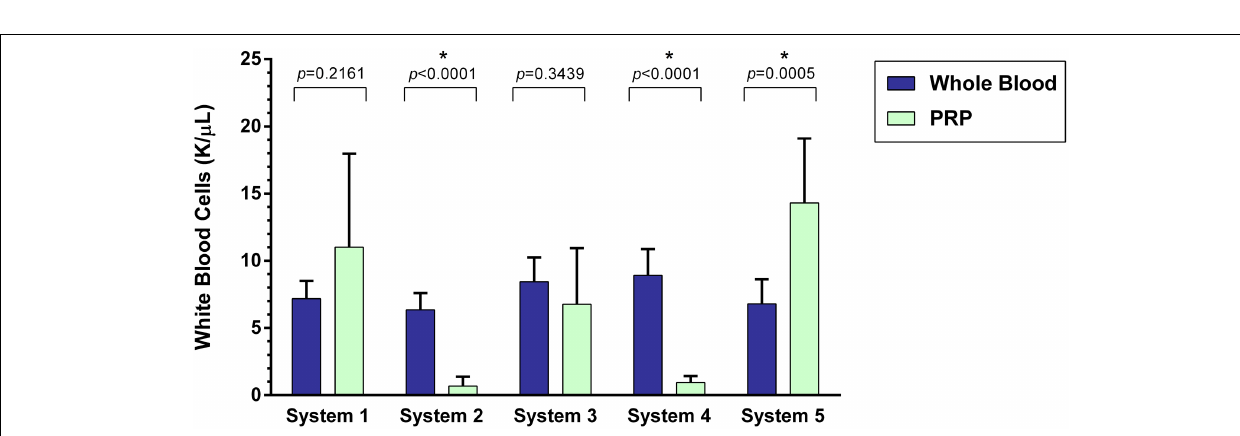
FIGURE 3 | Comparison of mean whole blood and mean PRP product WBC concentrations between five commercial PRP systems . An asterisk (*) indicates a statistically significant difference between the mean whole blood and mean PRP product for that PRP system. Bars represent mean (cid:6) 95% CI ( n = 10).